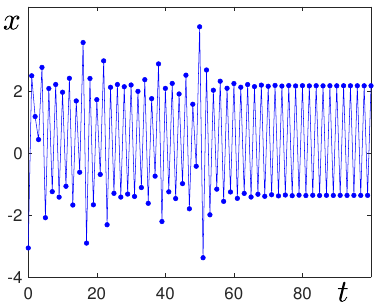
Figure 9. Chaotic transient in deterministic system (1) with σ = 0.8.